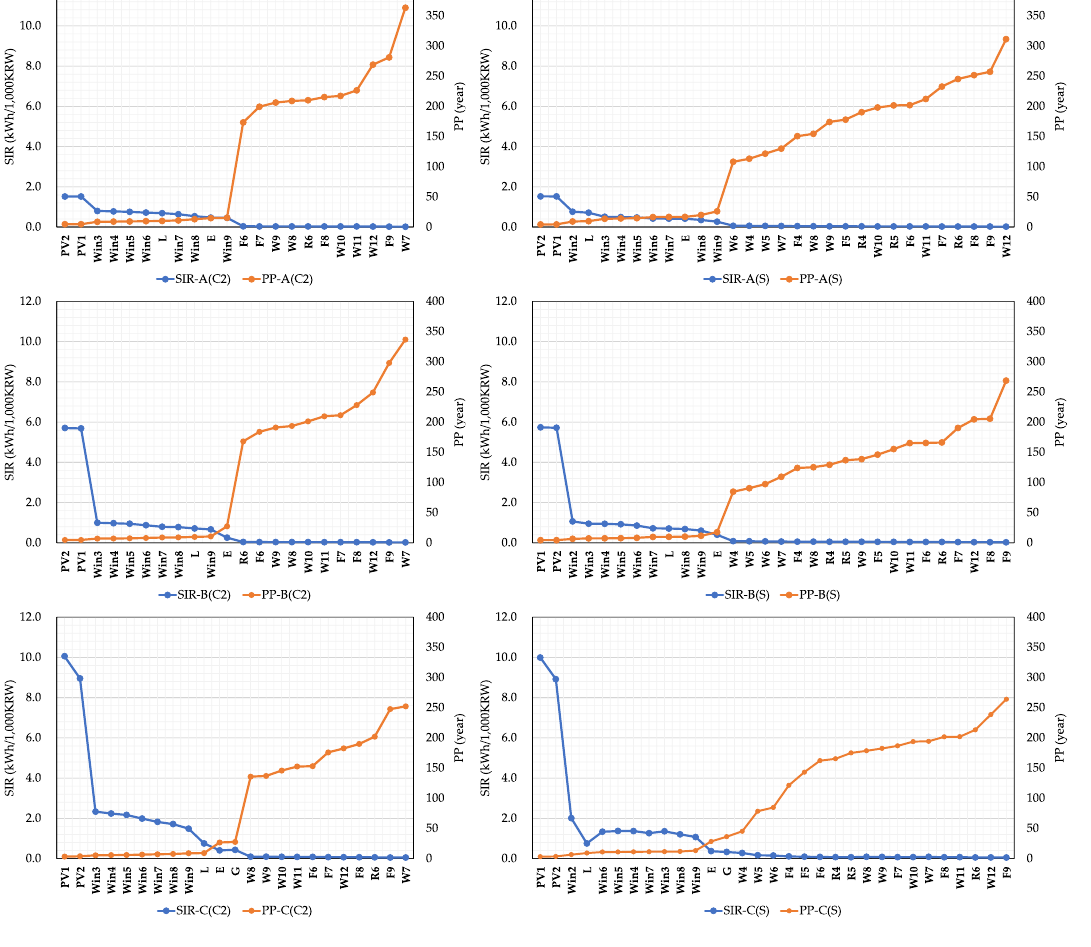
Figure 6. SIR and PP of the ECMs for each reference building in C2 and S regions.